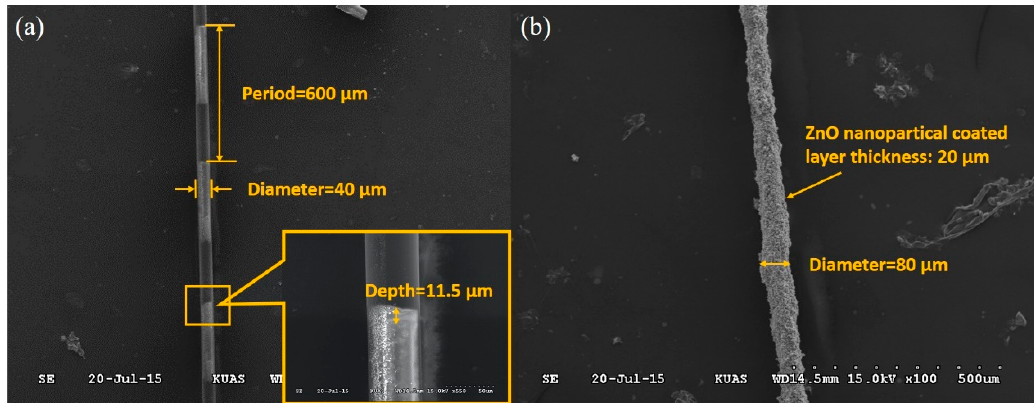
Figure 2. ( a ) SEM image of the LPFG. Inset: The notch depth of the LPFG; ( b ) SEM image of the ZnO nanoparticle-coated LPFG CO 2 gas sensor.